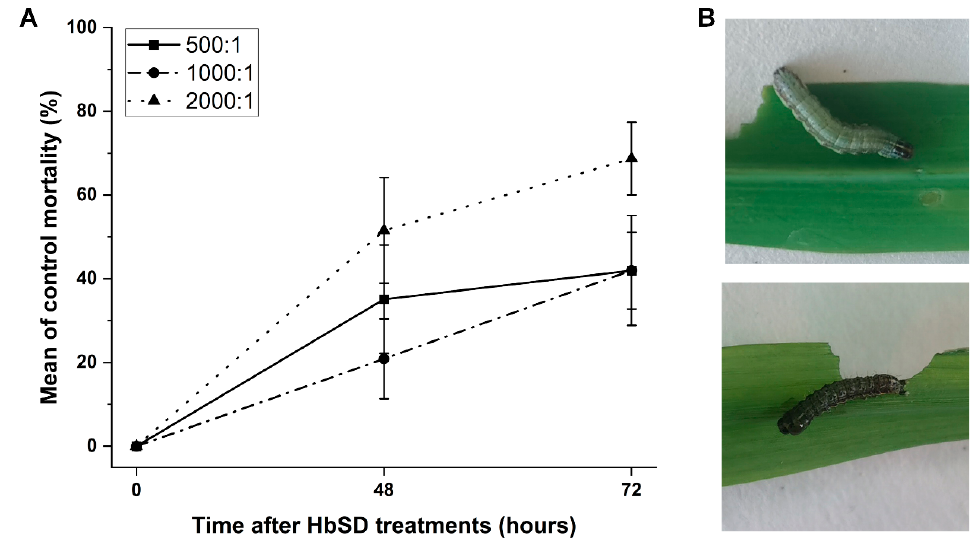
Figure 2. HbSD efficacy against S. frugiperda in potted soil bioassays. ( A ) The control mortality caused by HbSD infection at concentrations of 500:1, 1000:1 and 2000:1 per larva when treated for 48 h and 72 h. ( B ) The alive (above) and dead (below) larvae picked from corn leaves after treating with water or HbSD for 72 h.